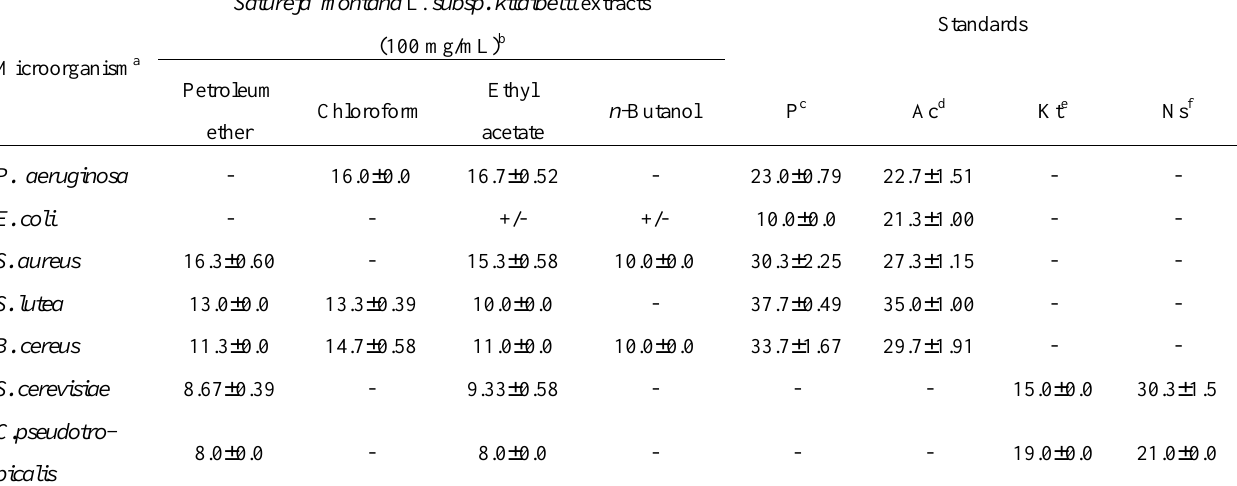
Table 1 . Antimicrobial activity of different Satureja montana L. subsp . kitaibelii extracts and referent